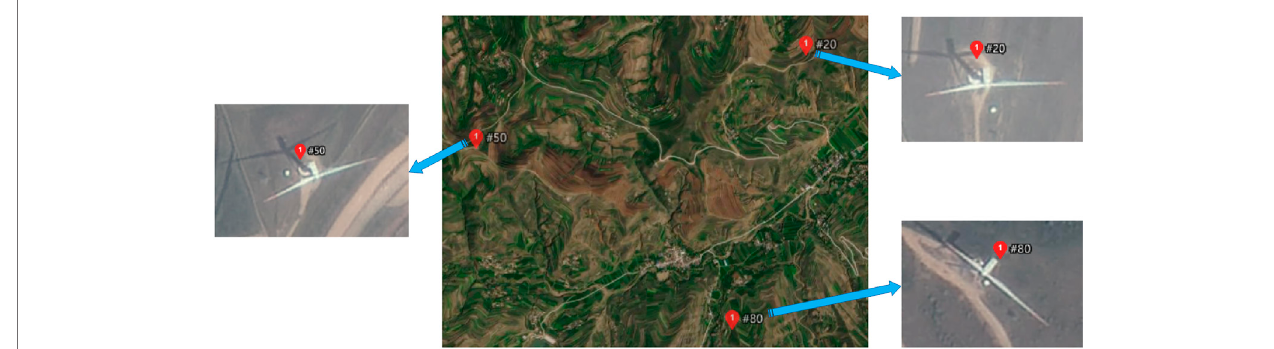
FIGURE 2 | Location distribution of wind turbines #20, #50, and #80.